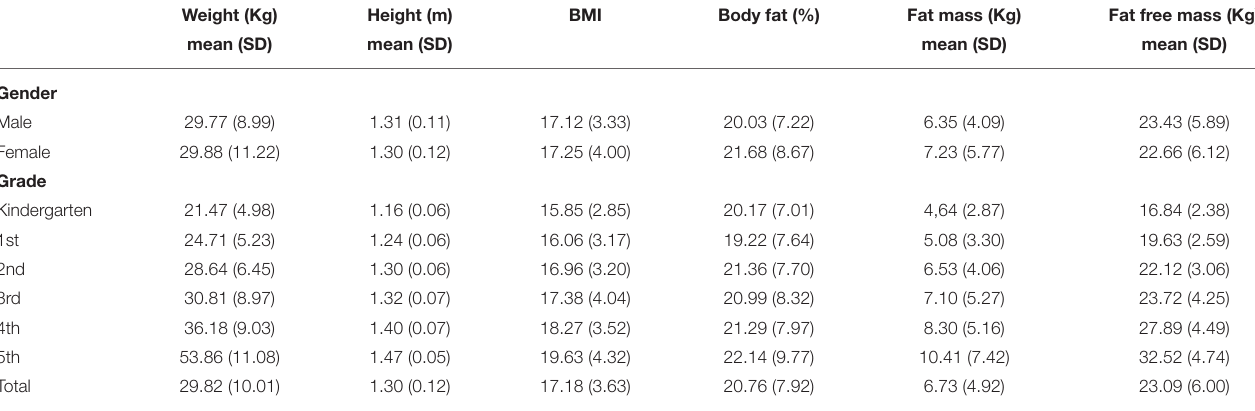
TABLE 2 | Descriptive statistics-means and standard deviations.